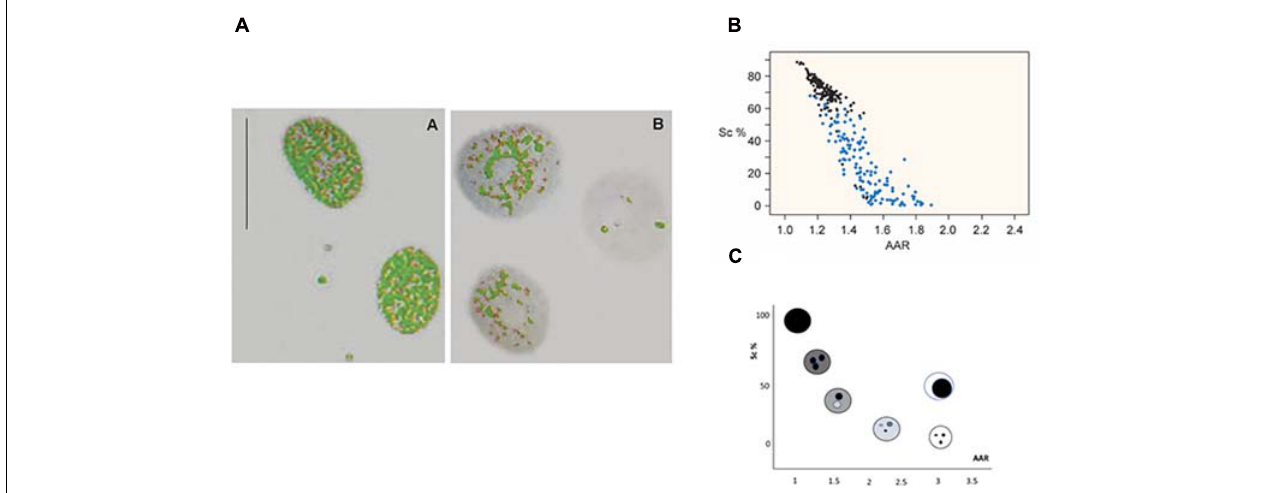
FIGURE 1 | Image analysis of VPA-treated chromatin. Images of VPA-treated Feulgen-stained HeLa cell nuclei show the decreased areas covered by condensed chromatin in gray color (A) [reprinted from Felisbino et al. (2011)—PLoS ONE 6: e29144]. A scatter diagram representing the Sc% vs. AAR relationship for Feulgen-stained HeLa cell nuclei shows nuclei treated with 1.0 mM VPA for 2 h (blue dots) compared with nuclei from the respective untreated control (black dots) (B) [reprinted from Felisbino et al. (2011)—PloS ONE 6: e29144]. Each dot in the plot represents one nucleus with a specific phenotype as shown in the theoretical model (C) [modified from Vidal et al.